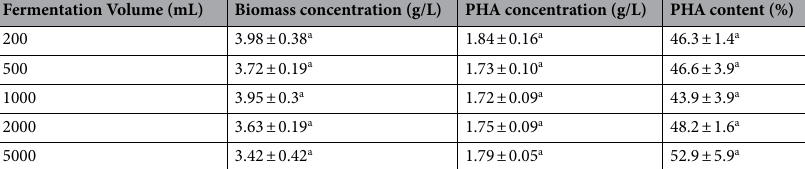
Fermentation Volume